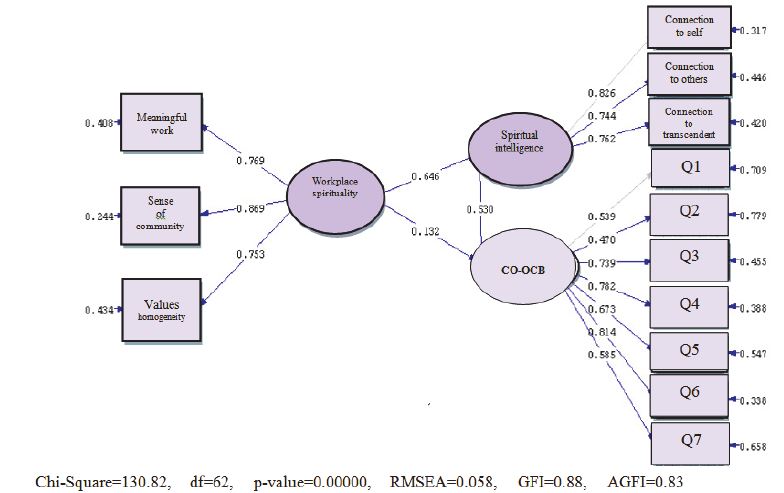
Fig. 9 . The estimation of general model